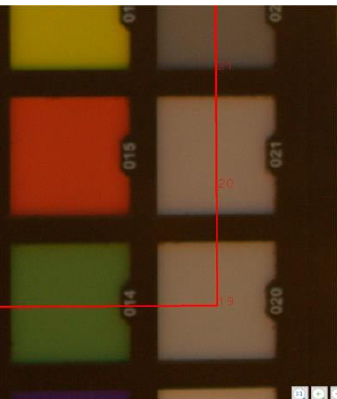
Figure 5. An example of a wrong match in the calibration tool. The solution to this problem was to rotate the X-rite Classic 24 panel and acquire images on the four positions (0º, 90º, 180º of rotation). Fig. 6 shows the ColorChecker panel rotated 90º left on a successful match in the calibration tool.